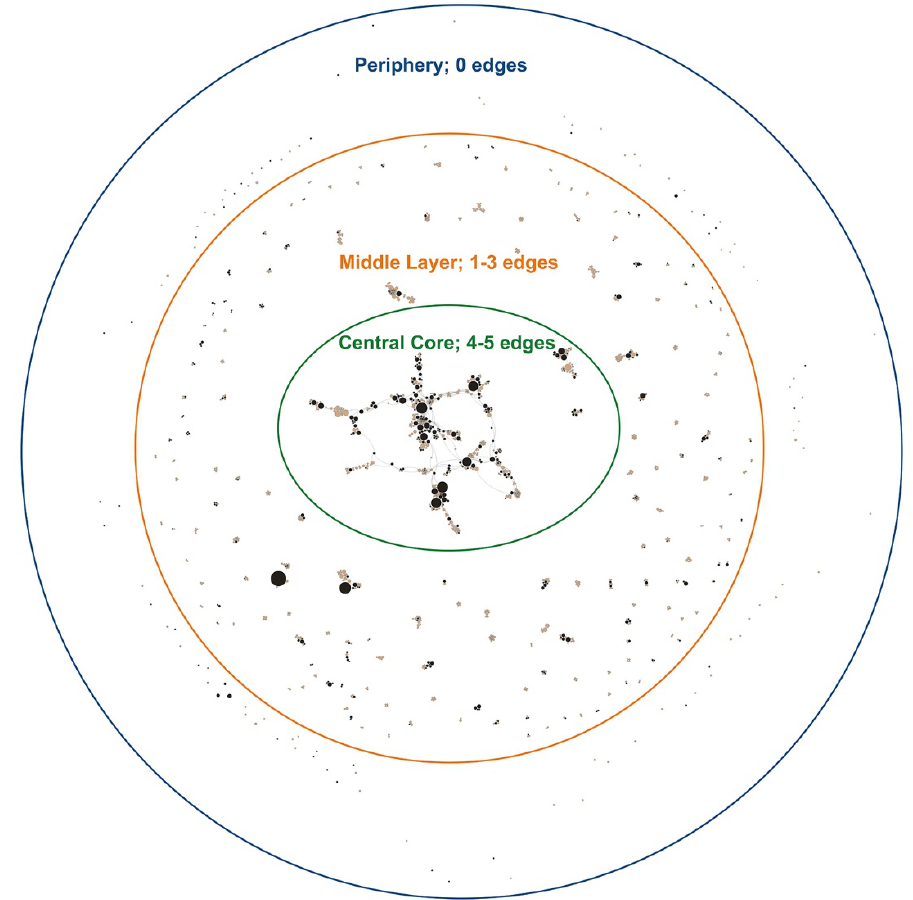
Nodes represent individual authors, sized by total number of published papers and color-coded for MLA membership status, with black indicating MLA members and tan indicating non-MLA members. Edges represent connectivity between authors. This network was created using Gephi; node placement was determined by the ForceAtlas2